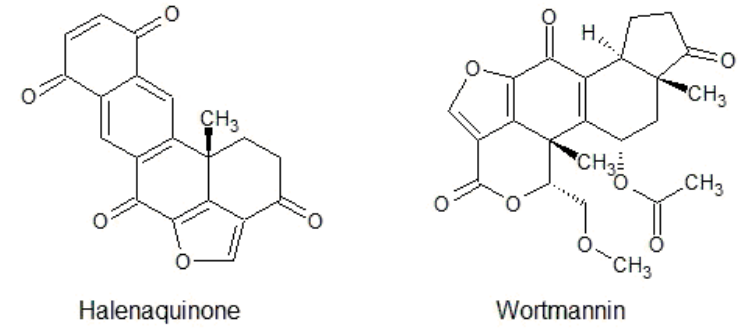
Figure 10. Chemical structures of natural furanosteroid derivatives.